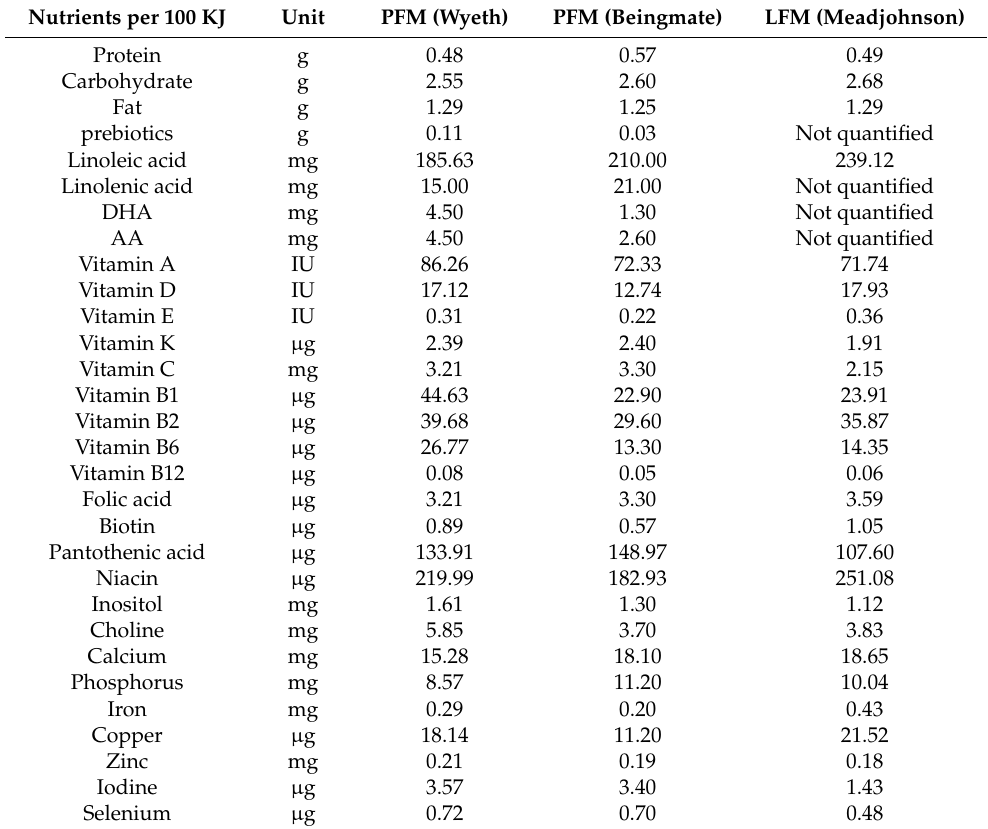
Table 2. The nutrient composition of the powdered formula milk (PFM) and liquid formula milk (LFM) evaluated in this